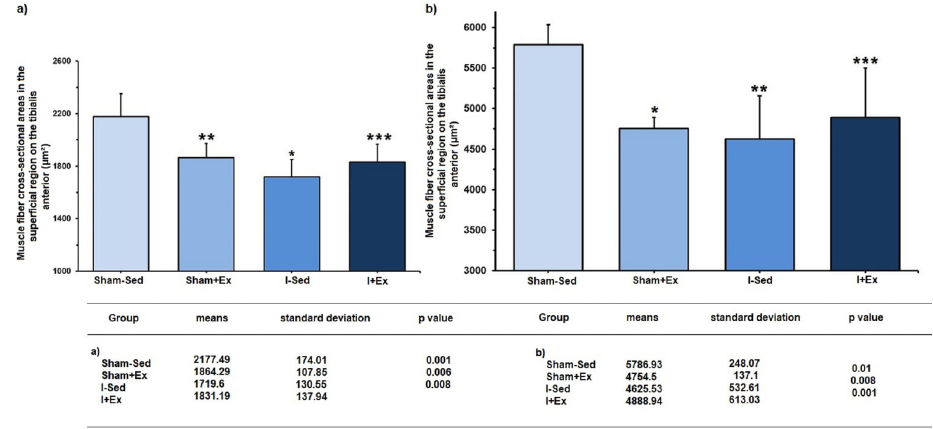
Figure 4. Muscle fi ber cross-sectional areas in the deep region of the tibialis anterior muscle. a , Type-I fi bers: *P=0.001; **P=0.006; ***P=0.008 vs Sham-Sed group. b , Type-II fi bers: *P=0.01; **P=0.008; ***P=0.001 vs Sham-Sed group (ANOVA, followed by the Newman-Keuls post- test). Sham-Sed: Sedentary control group; Sham + Ex: Control group exercised before the sham surgery; I-Sed: Sedentary ischemic group; I + Ex: Ischemic group exercised before occlusion of the middle cerebral artery